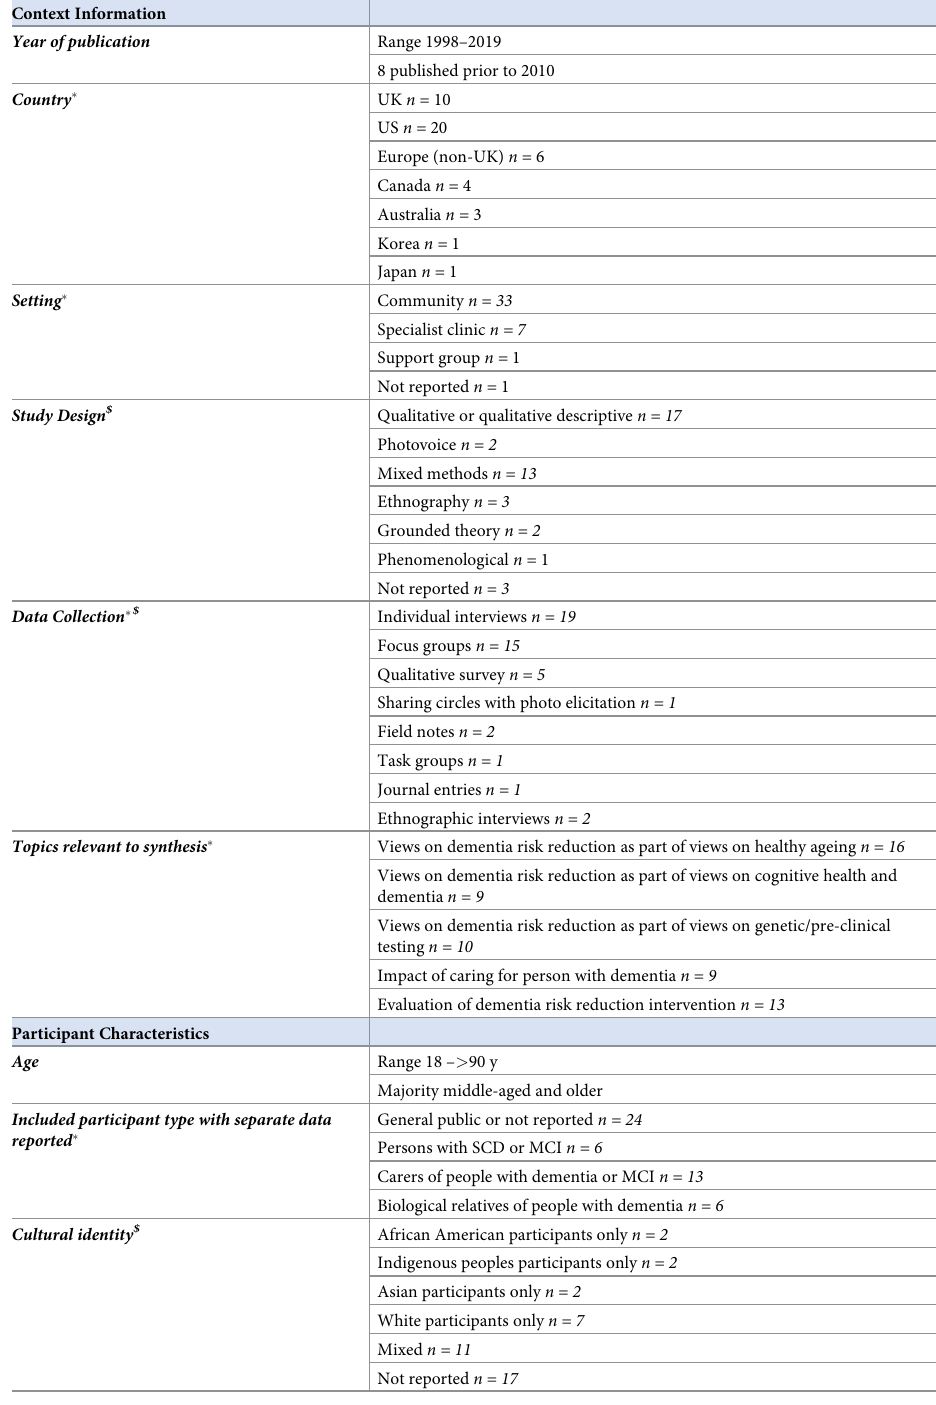
Table 1. Summary of studies included for original